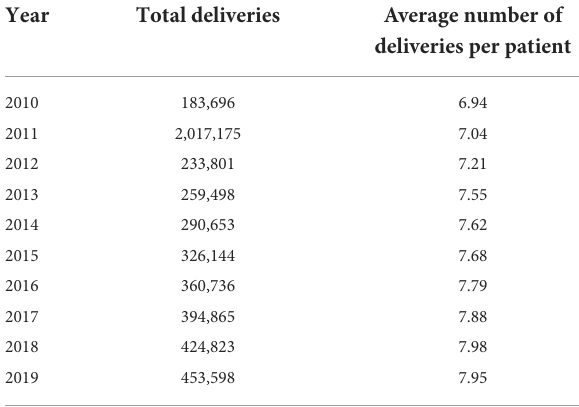
TABLE 5 Average number of MPH deliveries per year per patient.